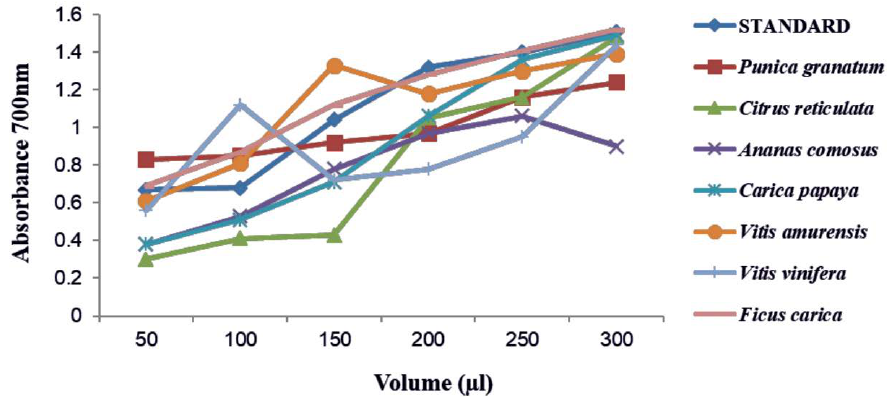
Fig. 3. Antioxidant activity by FRAP